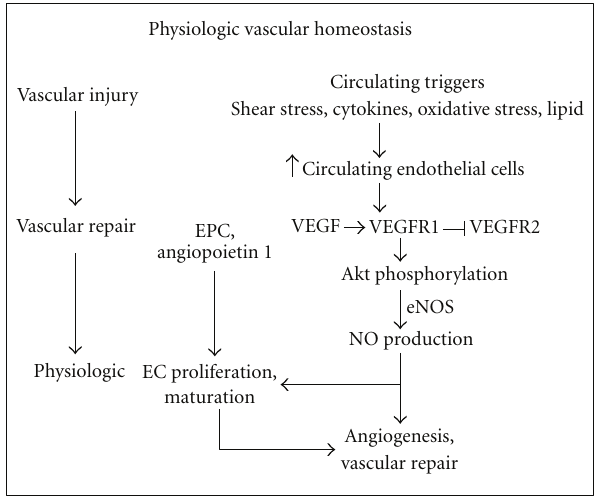
Figure 2: Vascular homeostasis under physiologic condition.